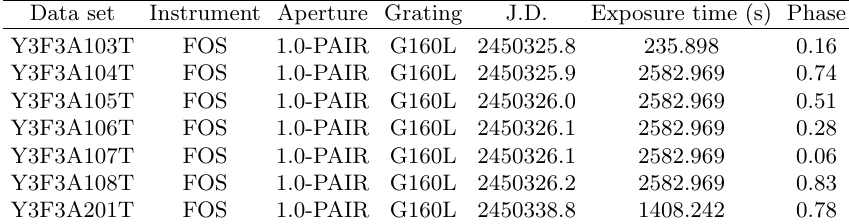
Table 3. Journal of HST observations of HU Aqr.